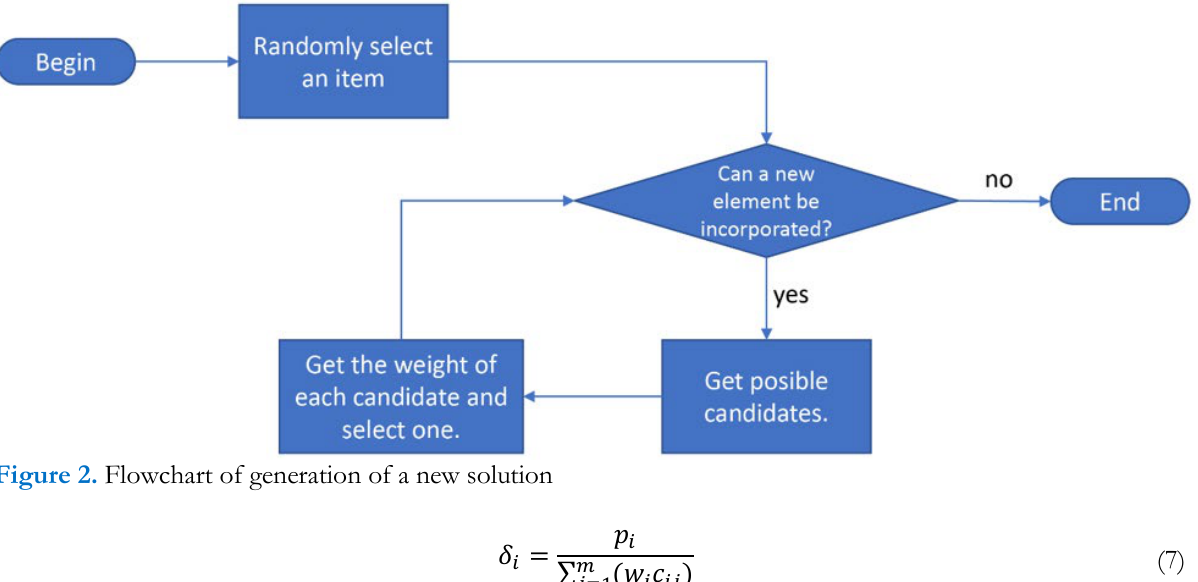
Figure 2. Flowchart of generation of a new